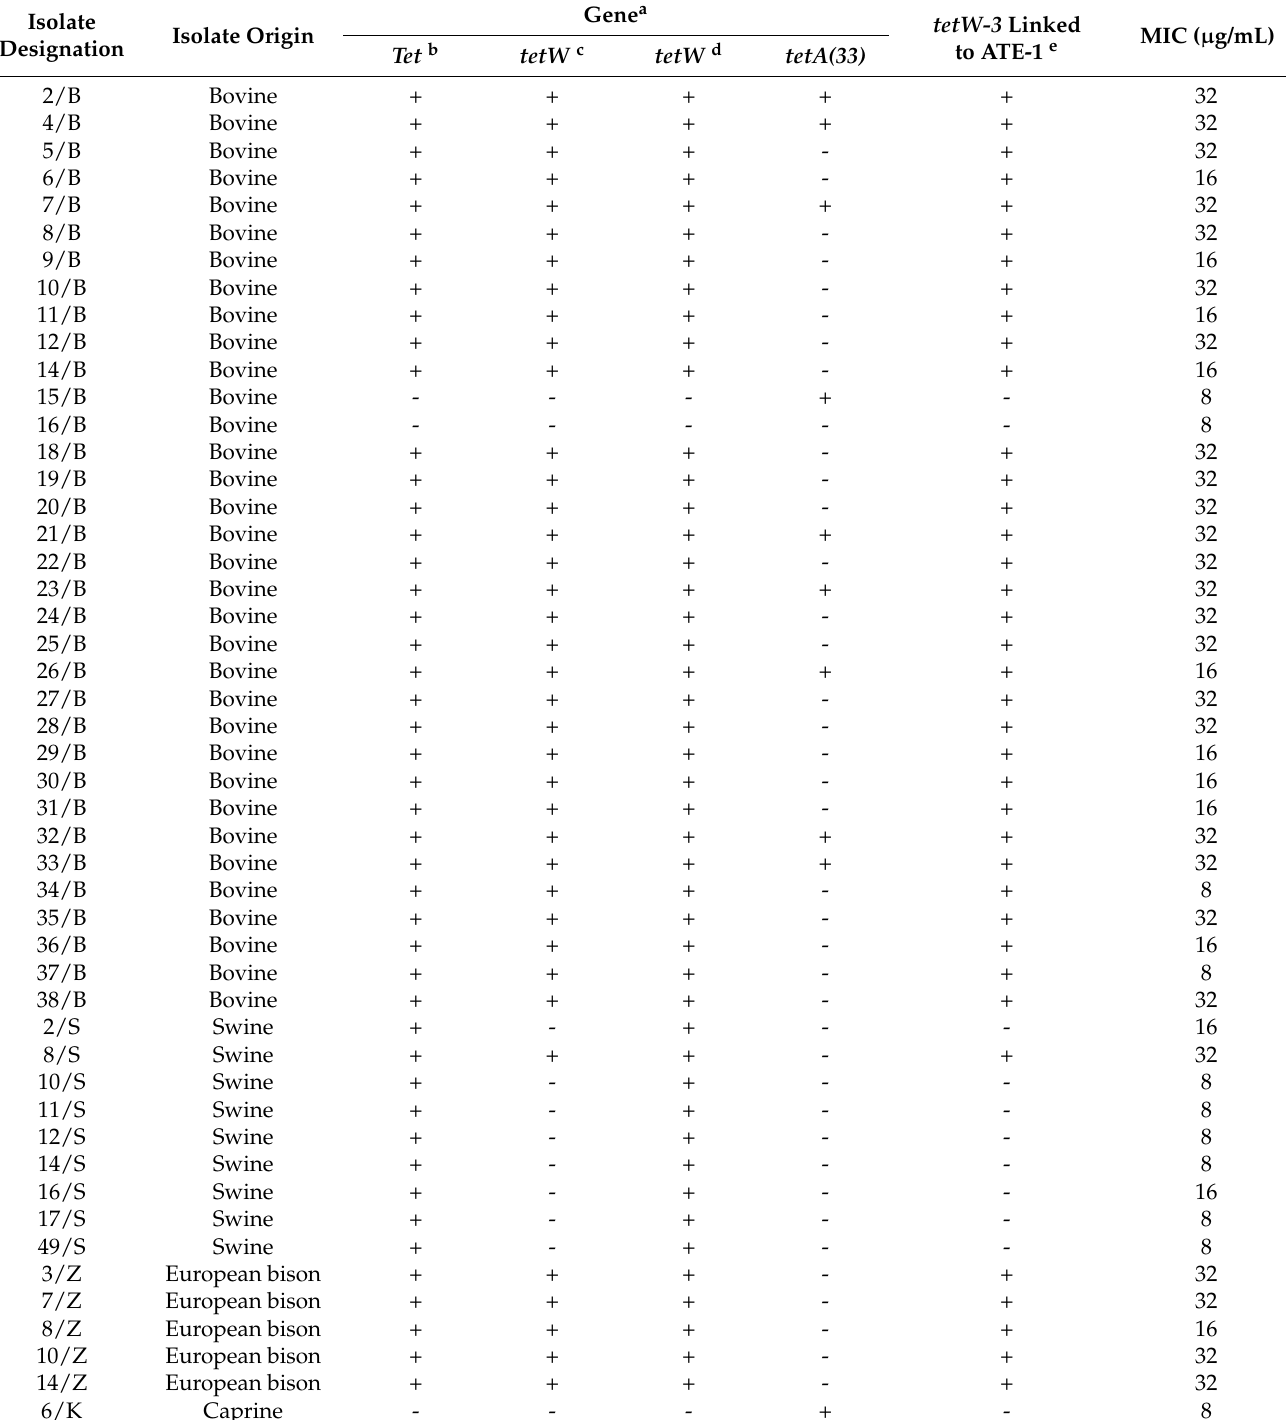
Table 2. Occurrence of the tetW and tetA(33) genes, tetW-3 linked to ATE-1 transposon, and the tetracycline MIC values for the tetracycline-resistant Trueperella pyogenes isolates ( n = 49). The presence of tetW was tested using two different primer